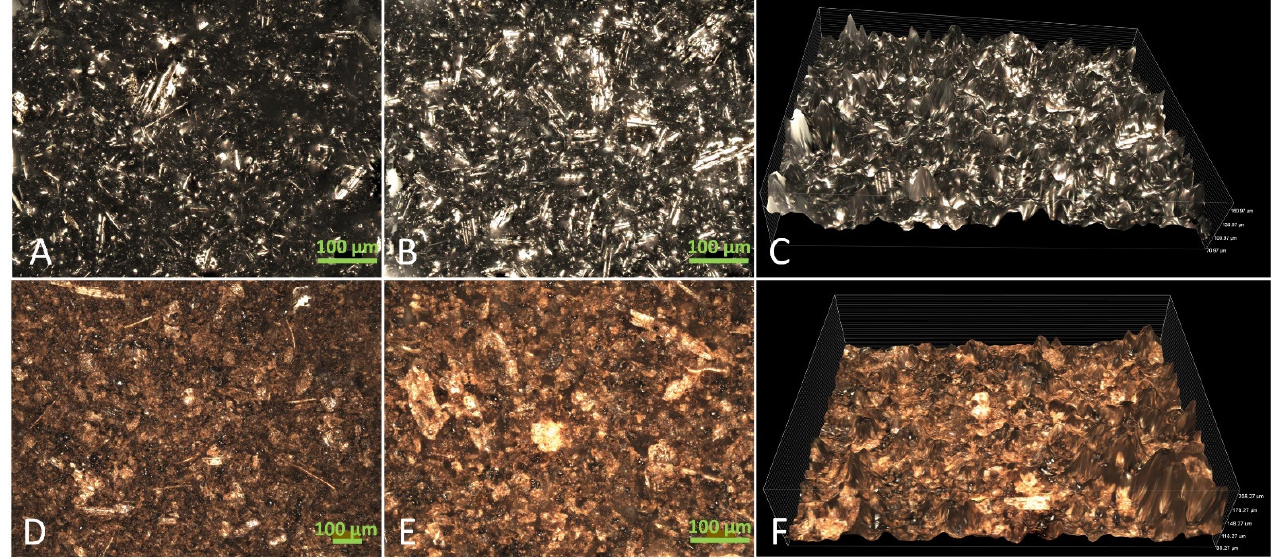
Figure 6. Images of samples: ( A ) AC/He, ( B ) AC/Ar, ( C ) AC/Ar, ( D ) BSG-HC/He, ( E ) BSG-HC/Ar, ( F ) BSG-HC/Ar.